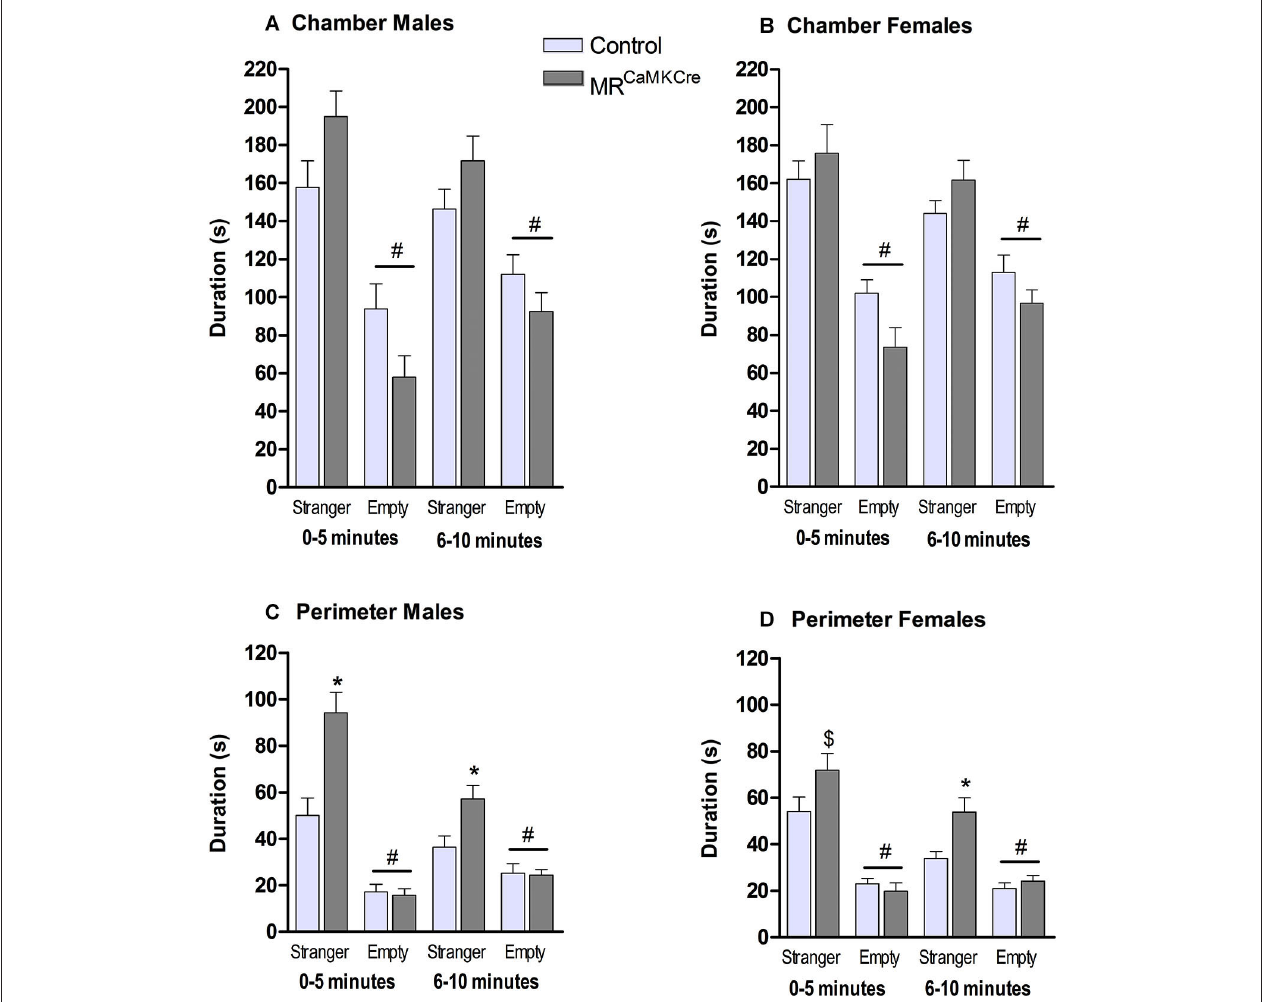
9 (males); n = 15 (females)) and dark grey the MR CaMKCre mice ( n = 8 (males); n = 16 (females)). * p < 0.05 compared to controls same treatment; # p < 0.05 compared to the stranger chamber/perimeter. $ p < 0.05 compared to males. All data are expressed as mean ±